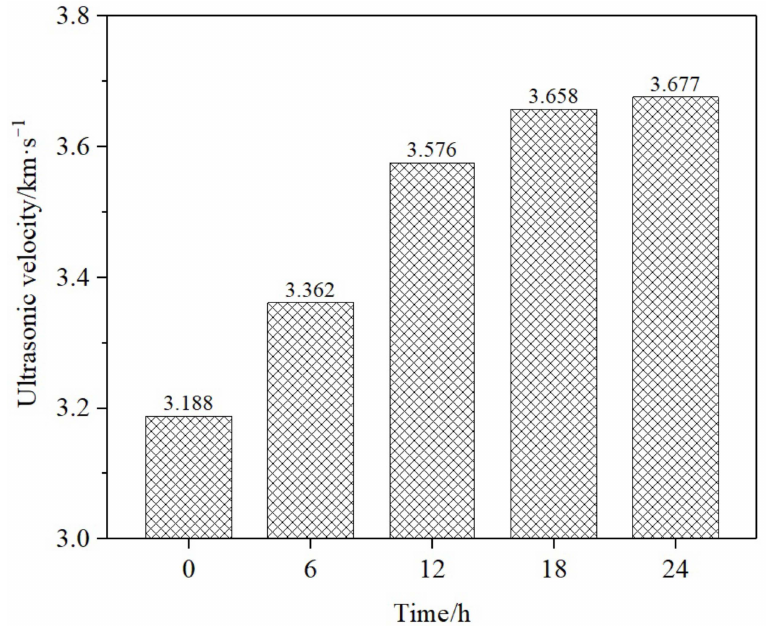
Figure 7. Ultrasonic